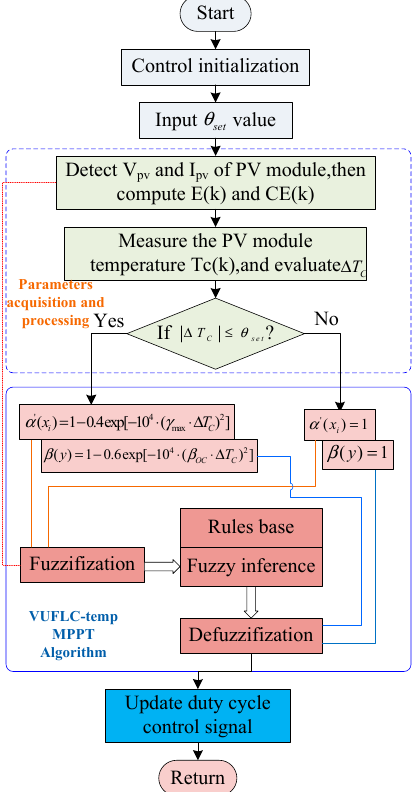
Figure 8. Flowchart of the proposed variable universe fuzzy logic control temperature (VUFLC-temperature) MPPT control algorithm procedure.